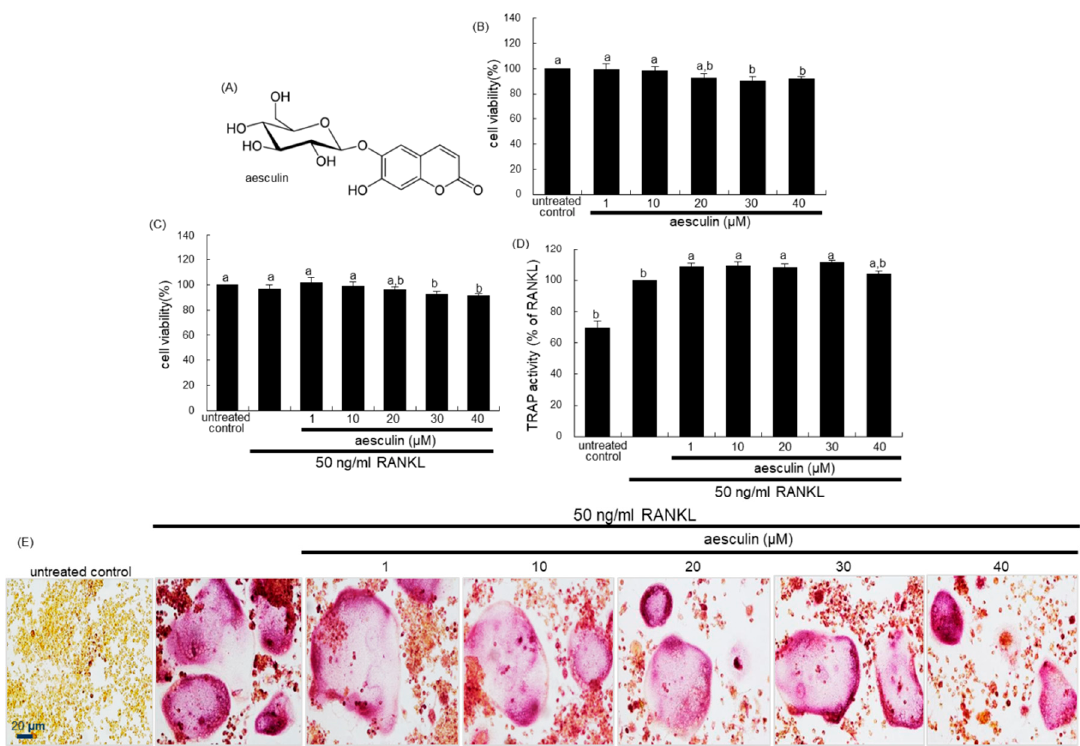
Figure 2. Chemical structure of aesculin ( A ), cytotoxicity of Raw 264.7 macrophages by 1–40 μ M aesculin ( B , C ), and inhibitory effects of aesculin on tartrate-resistance acid phosphatase (TRAP) activity ( D ) and staining ( E ). Raw 264.7 cells were cultured for 3 days with 1–40 μ M aesculin in the absence and presence of 50 ng/mL receptor activator of nuclear factor- κ B ligand (RANKL). Cell viability was measured by 3-(4,5-dimetylthiazol-yl)-diphenyl tetrazolium bromide (MTT) assay ( B , C ). Bar graphs for viability (mean ± SEM, n = 3) are expressed as percentage cell survival compared to untreated cells. For the TRAP activity and staining ( D , E ), Raw 264.7 cells were cultured for 5 days with 50 ng/mL RANKL in the absence or presence of 1–40 μ M aesculin. TRAP activity (mean ± SEM, n = 3) was measured at λ = 405 nm. TRAP-positive multinucleated osteoclasts were observed under light microscopy (four separate experiments). Scale bar = 20 μ m. Respective values in bar graphs not sharing a small letter are significantly different at p < 0.05.